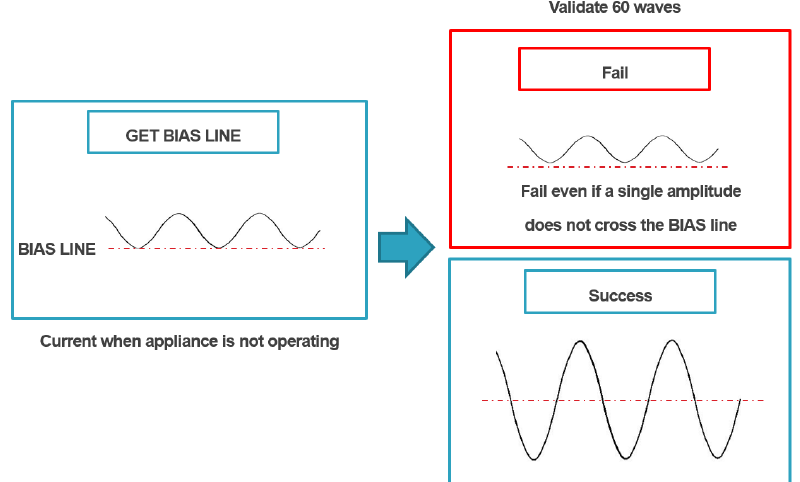
Figure 15. Initialization process.